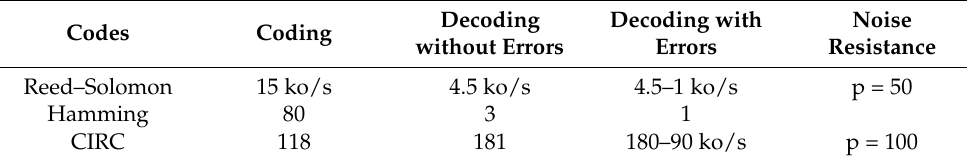
Table 3. Comparison between some correction